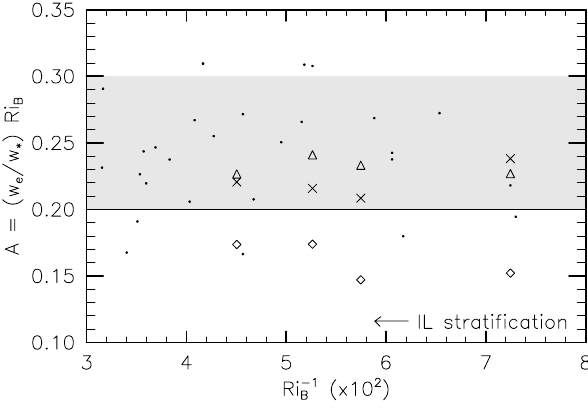
Fig. 10. Dimensionless parameter A = (w e /w ∗ )Ri B for the differ- ent times displayed in Table 1 as a function of Ri − 1 puted by three methods: from the LES (using its definition d t z i ) ( 4 ); from Eq. ( 23), with K = K L averaged over the interfacial layer ( × ); by the simple model (24) ( (cid:5) ). Convection tank measurements of Deardorff et al. (1980) are included for comparison ( · ). The filled area represents A in the range